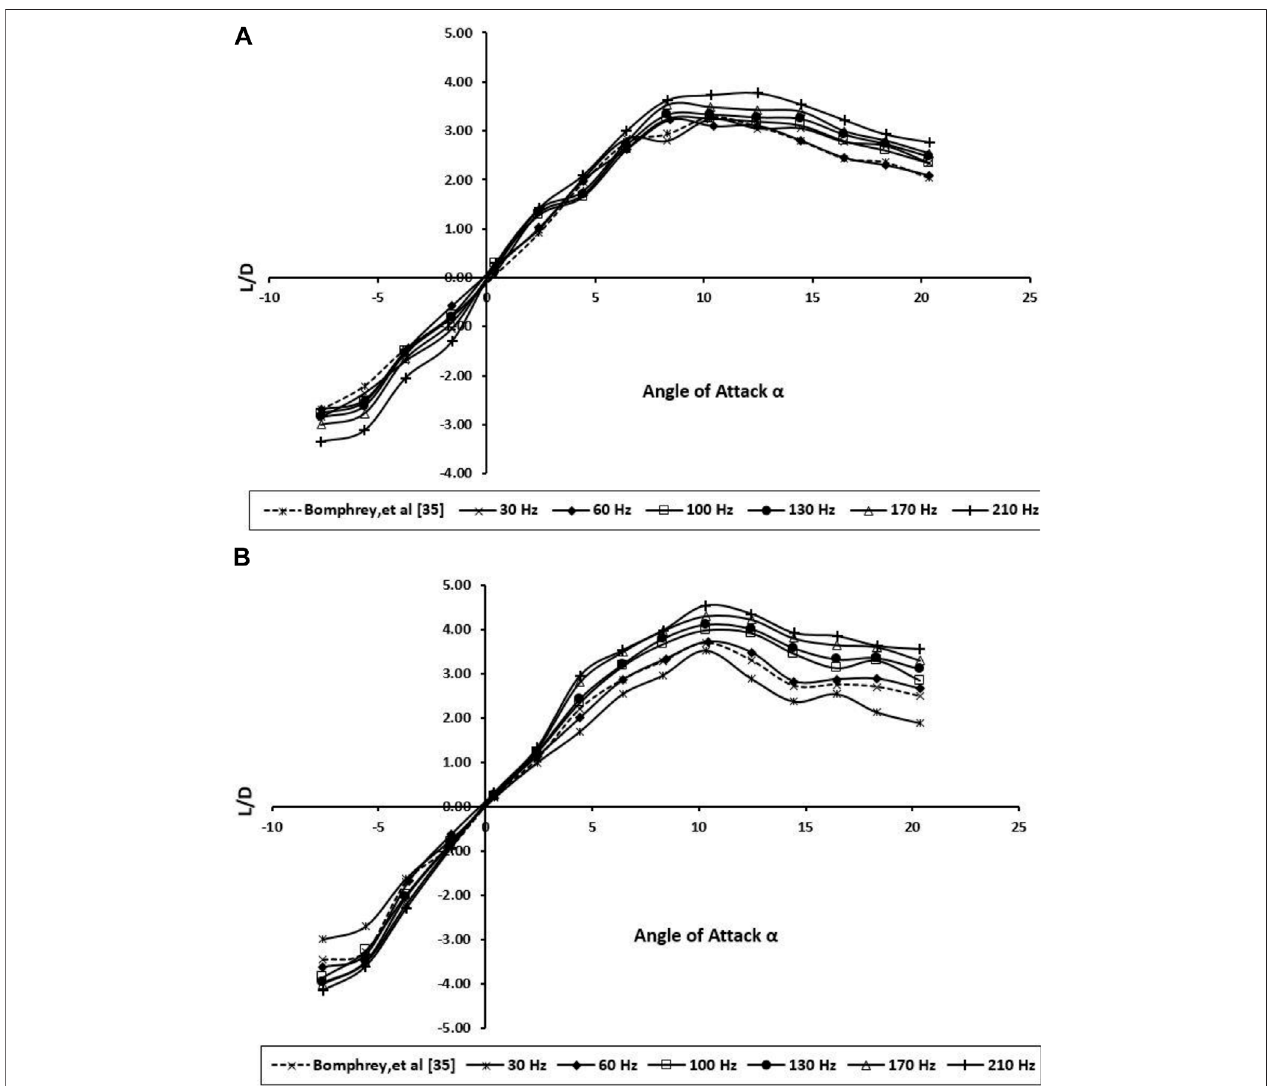
FIGURE 10 | Lift-to-drag ratio for the BMAV ’ s wing at various angles of attack and wing beat frequencies; (A) forewing; (B)